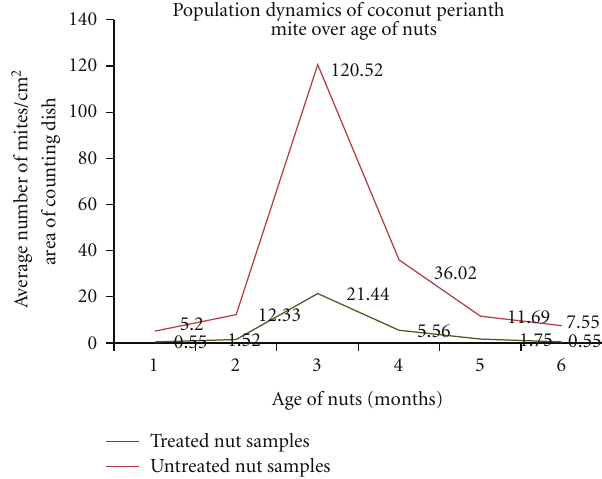
Figure 1: E ff ect of botanical biocide on average number of mites with respect to age of